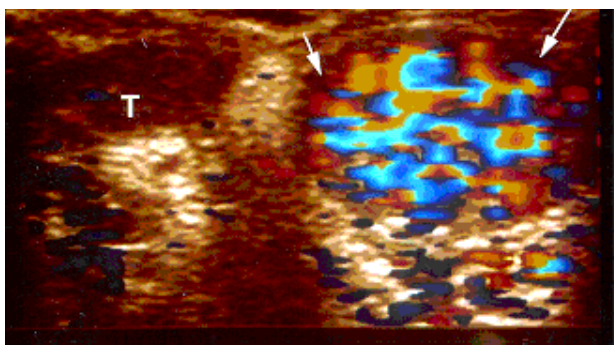
FIGURE 1B . Transverse Power Doppler Ultrasound of both testis demonstrates the diffuse increased flow to the splenic tissue (arrows) when compared to the small amount of normal flow seen in the right testicle